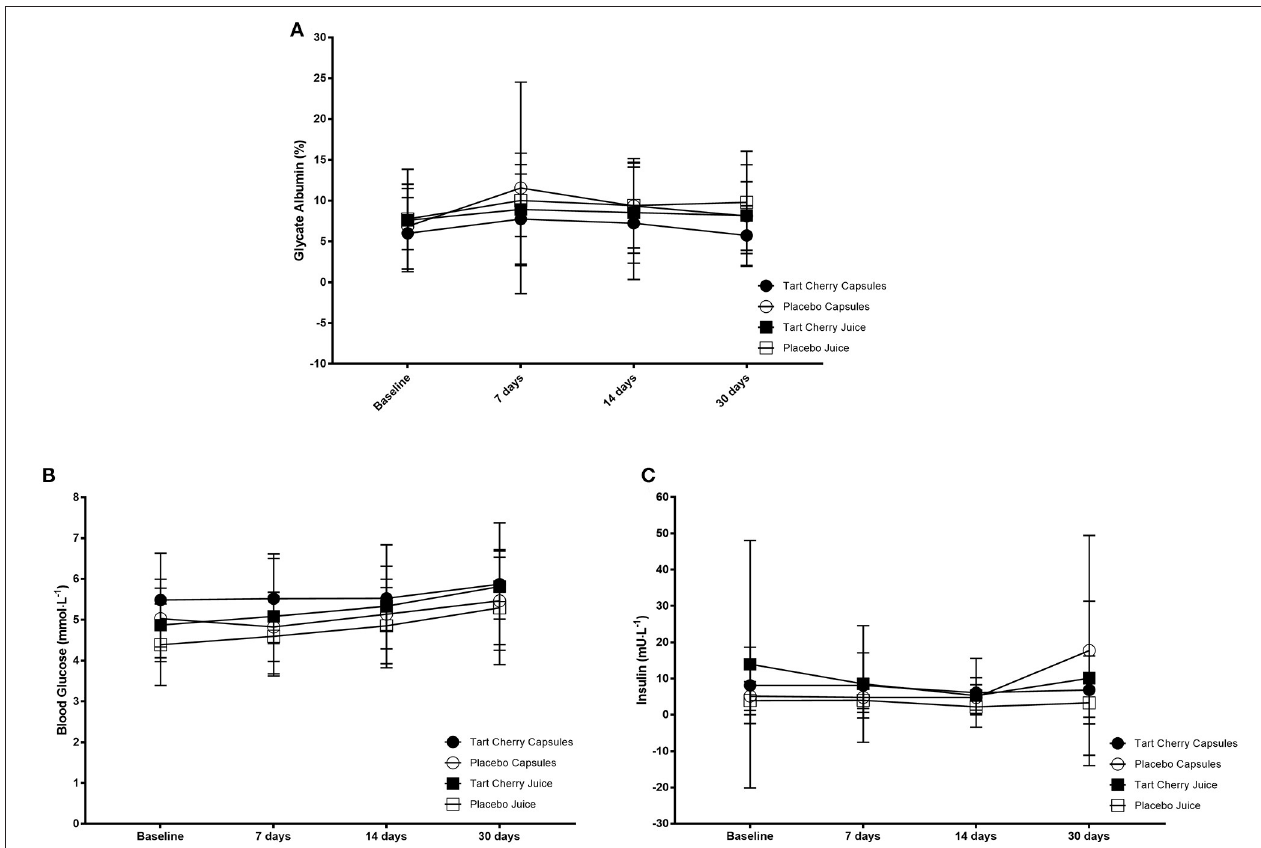
FIGURE 5 | Glucose regulation markers including glycated albumin (A) , blood glucose (B) , and insulin (C) concentrations for each group at baseline and after 14 and 30 days of supplementation with placebo or Montmorency tart cherry (MTC) concentrate or